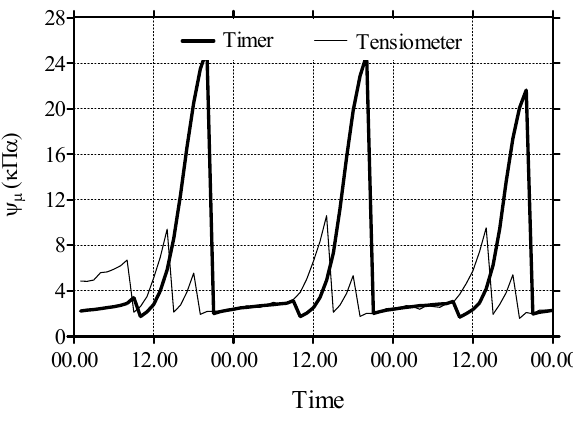
in pots with Hypericum hidcote plant as recorded m